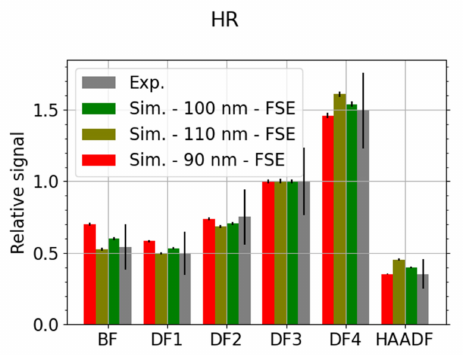
Figure 6. C—comparison of three simulated thicknesses and experimental data for HR microscope mode, E L = 15 keV. The data have been scaled to the segment DF3 and the MC simulated electrons, cor- responding to 10 6 incident particles, were freely propagated to the segmented detector. Contribution of the SEs is marginal in the HR mode.